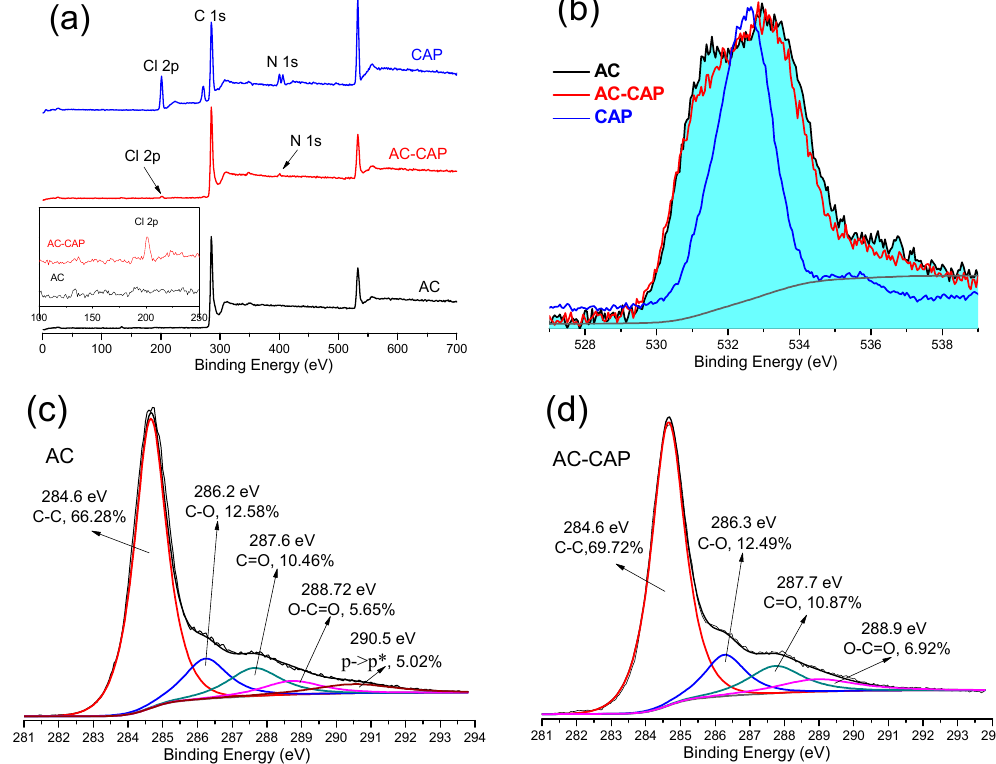
Figure 6. XPS survey spectra of AC, AC-CAP and CAP ( a ); O 1s ( b ); C 1s ( c ) and ( d ). Table 7. The atomic ratio of the samples.